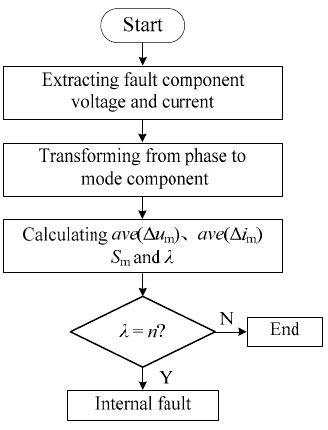
Figure 5. Identification flowchart of the busbar fault.